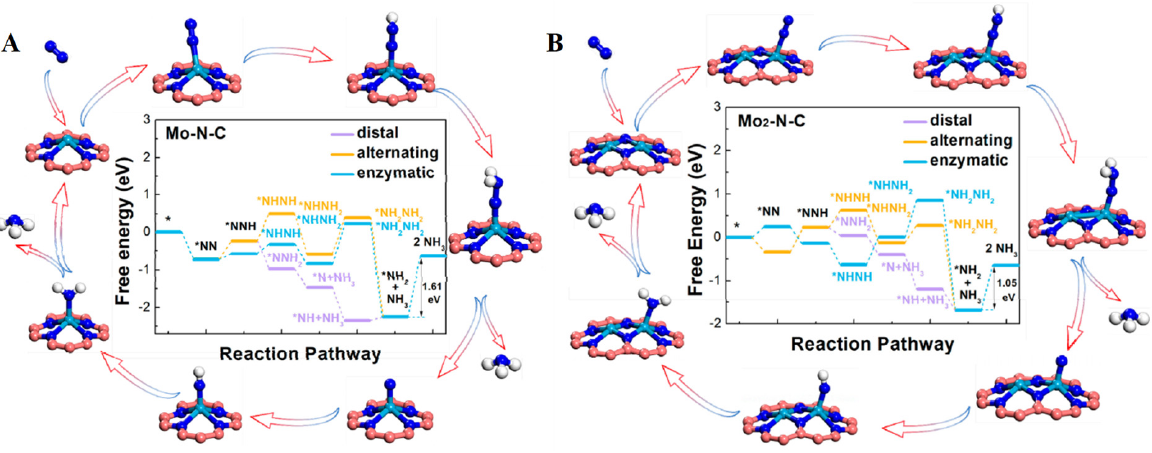
Figure 3. Free Energy representation for the nitrogen reduction reaction on the ( A ) Mo 2 ‐ N ‐ C and Mo ‐ N ‐ C ( B ) catalysts [61].